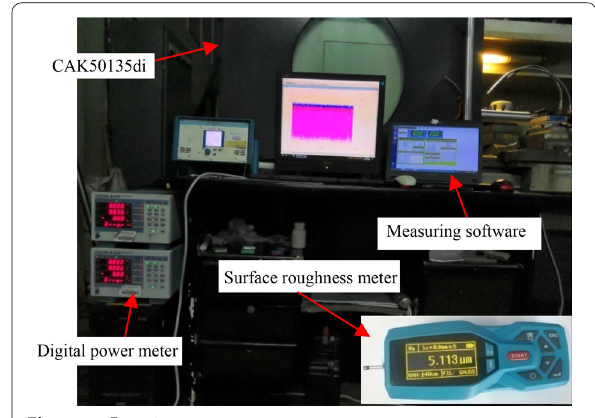
Figure 4 Experiment setup